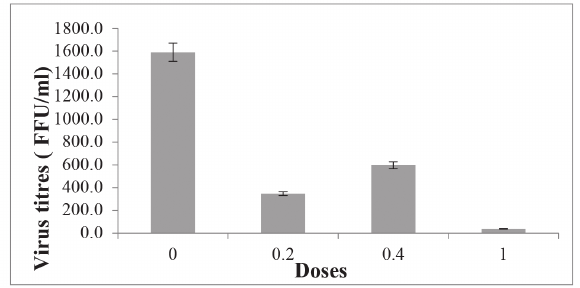
Figure 2. Titer of DENV after CA oral administration on Mice in- fected DENV-2 with a Variation of Doses 0, 0.2, 0.4, and 1 g/kg